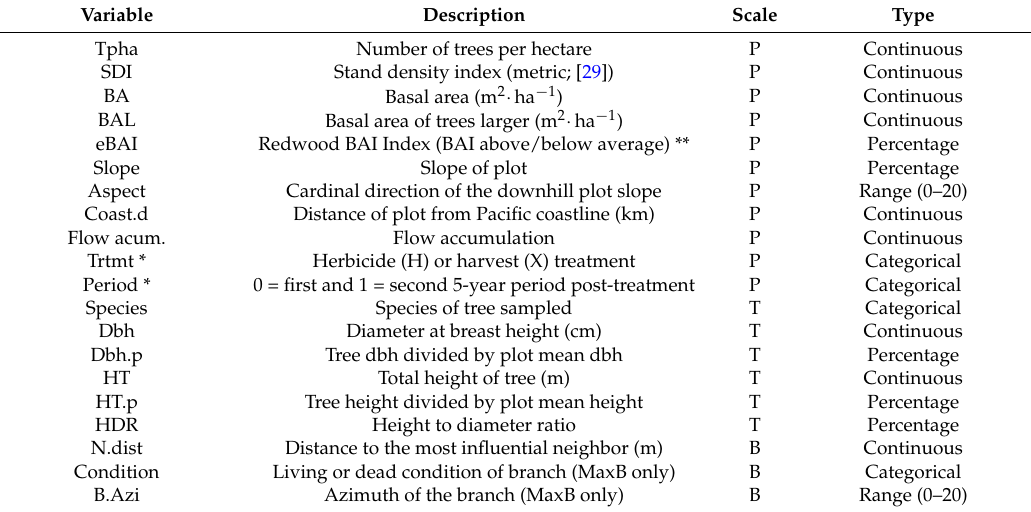
Table 1. Candidate variables for maximum branch (MaxB) size, BIX, and inventory models of branch diameter and branch growth for redwood and Douglas-fir in the overstory of multiaged stands in Mendocino County, California.